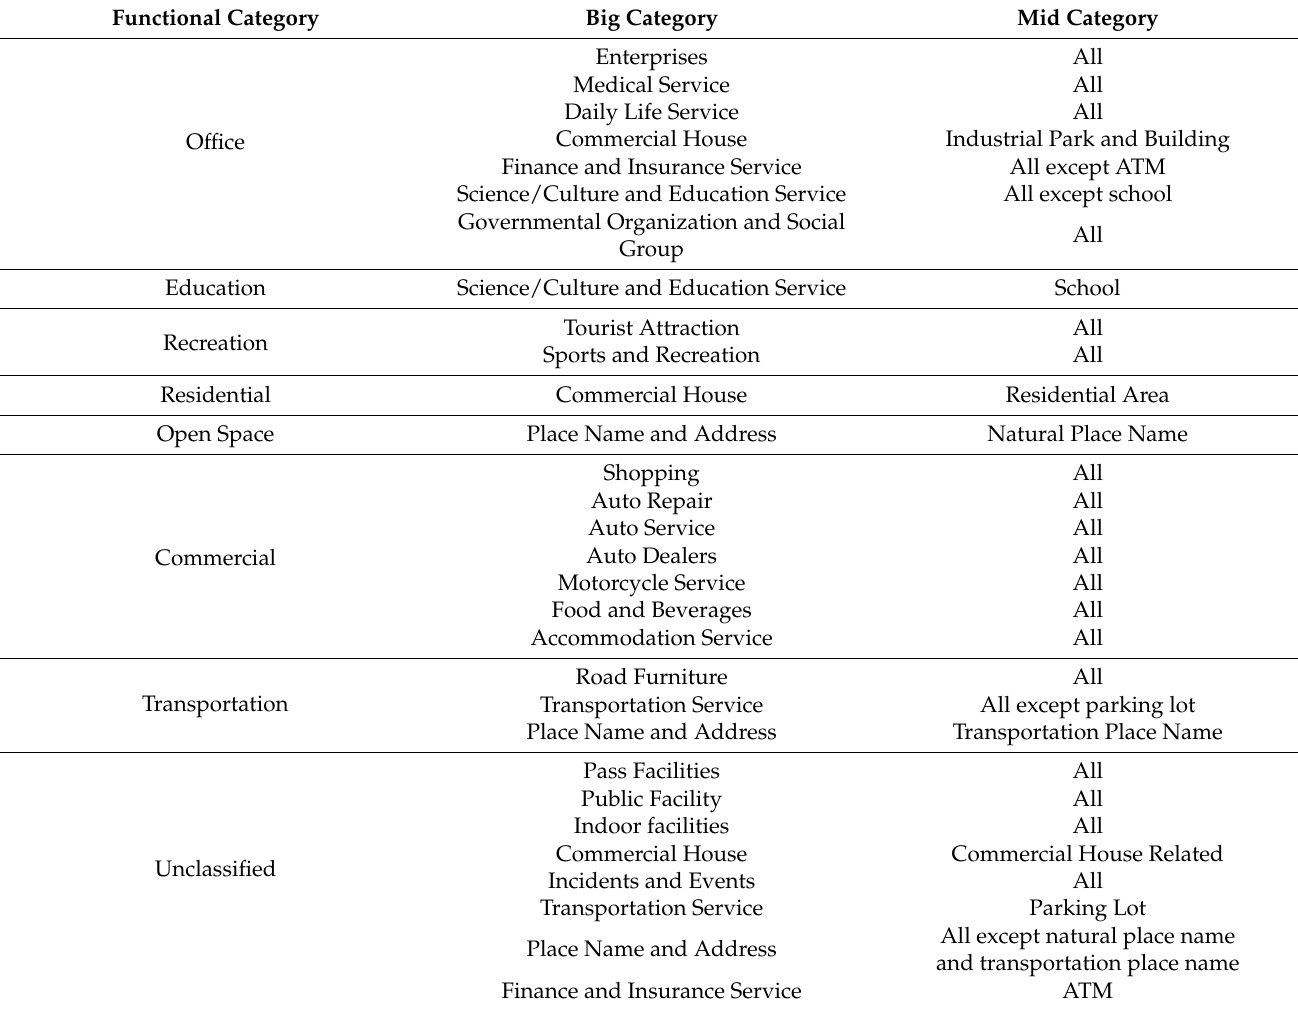
Table 2. The list of reclassified functional categories of